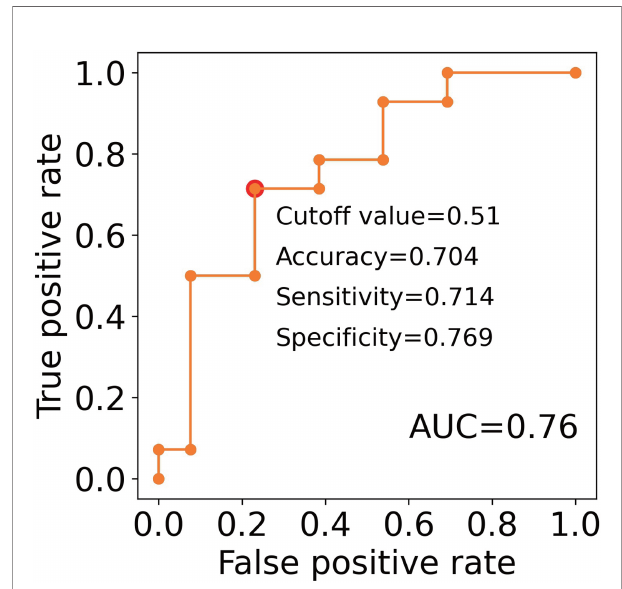
FIGURE 5 | An evaluation of the clinical utility of the combinations of predictive markers. ROC curves for non-response to TNFi. The model created by the multiple linear regression was as follows; 2.0×10 -3 × HGF (pg/mL) + 6.2×10 -4 ×CXCL10 (pg/mL) - 0.13×Number of lymphocytes (10 6 / m L) + 0.13. Red plots indicate the cut-off points at the highest accuracy (minimum false negative and false positive results) for predicting